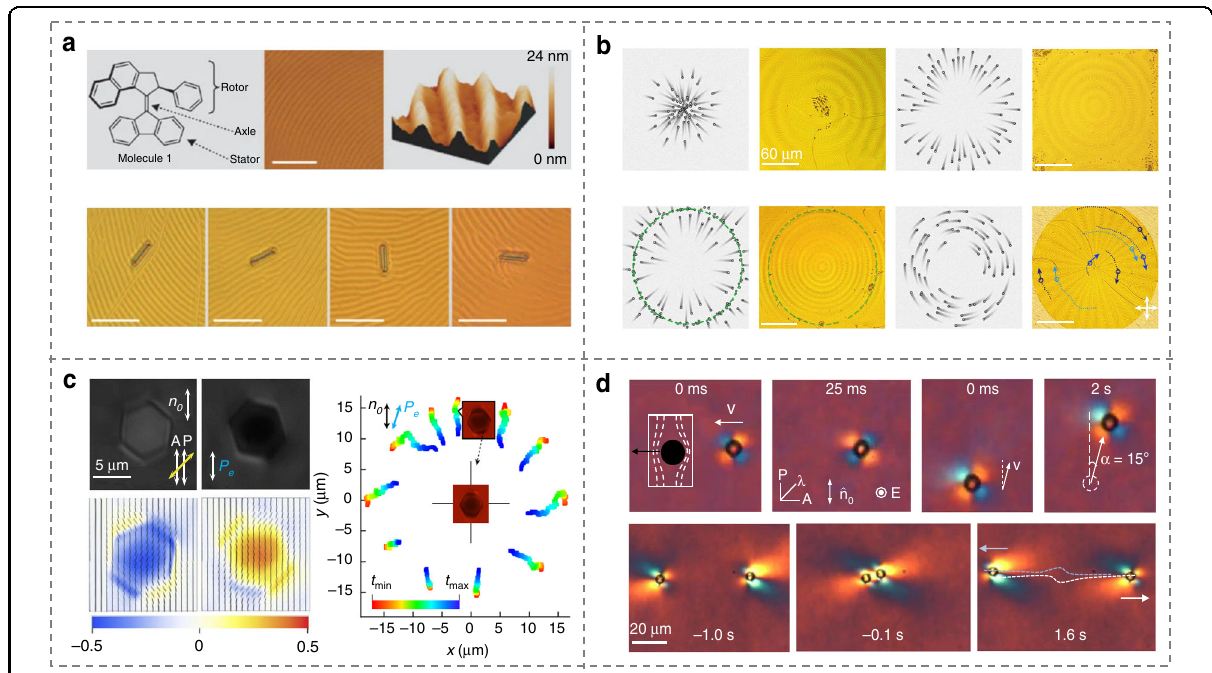
Fig. 14 LC-based soft actuators. a Rotary manipulators based on photoresponsive CLC fi ngerprints 264 . Reproduced from ref. 264 , with permission from Springer Nature: Nature. b Programmable self-propelling actuators enabled by a dynamic helical medium 30 . Adapted from ref. 30 , with permission from AAAS. c Self-assembled recon fi gurable colloidal monopoles 266 . Adapted from ref. 266 , with permission from Springer Nature: Nature. d Particle manipulation based on soliton-induced electrophoresis 75 . Adapted with permission from ref. 75 . Copyright 2020, American Physical Society